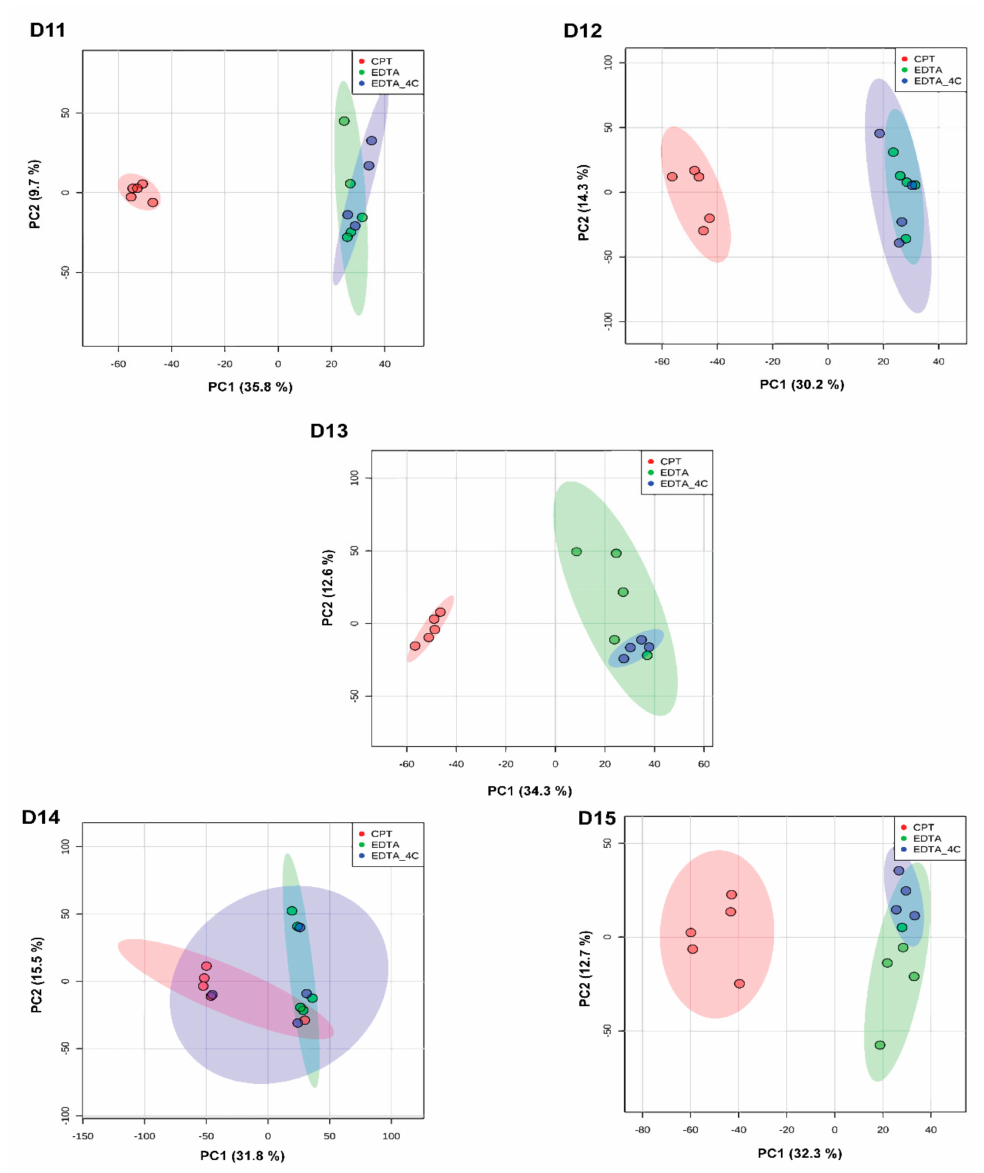
Figure 7. Principal component analysis among donor-matched samples grouped by anticoagulants for metabolomics data acquired in positive ionization mode. The PCA analyses showed di ff erences in lipid profiles between CPT and EDTA. The colored ellipse represents the 95% confidence